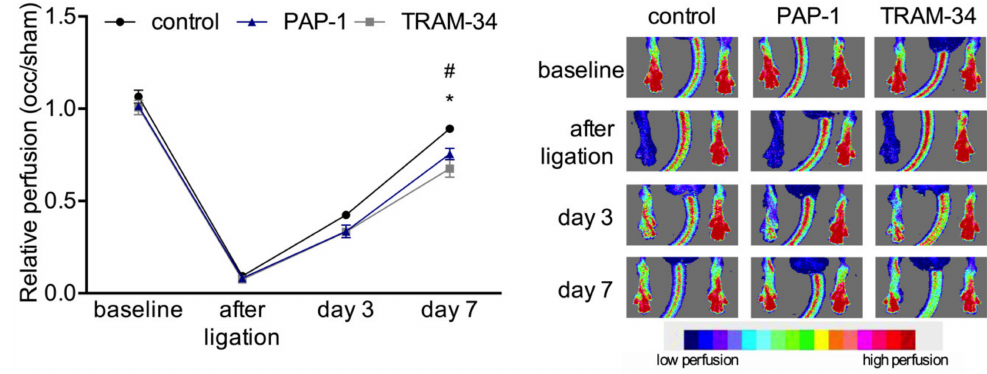
Figure 4. Laser Doppler perfusion measurements. Line plot (left panel) along with corresponding flux images (right panel) of laser Doppler perfusion measurements. Mice were treated with solvent (control), PAP-1, or TRAM-34, respectively, and the perfusion was calculated by right to left (occlusion (occ) to sham) ratio before, immediately after, and at day 3 and 7 after the surgical procedure (left panel). Data are means ± SEM, n = 6 per group. * p < 0.05 (PAP-1 vs. control) and # p < 0.05 (TRAM-34 vs. control) from two-way ANOVA with Bonferroni’s multiple comparison test. The right panel shows representative flux images of murine paws with the tail in the center. Cold colors (blue, green) indicate low perfusion, whereas warm colors (yellow, red) indicate high perfusion (see